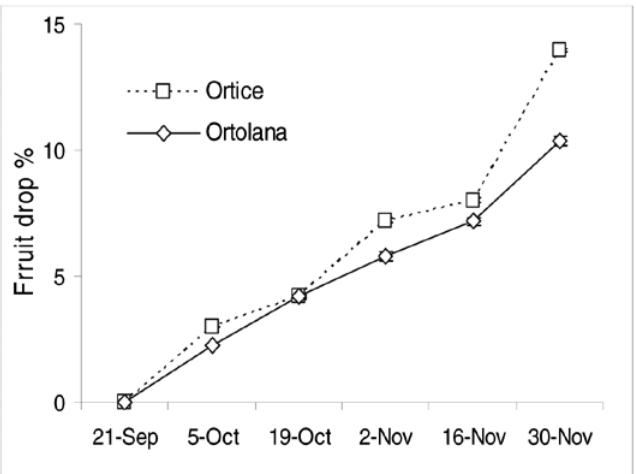
error).Fig. 5 - Evolution of pre-harvest fruit drop during